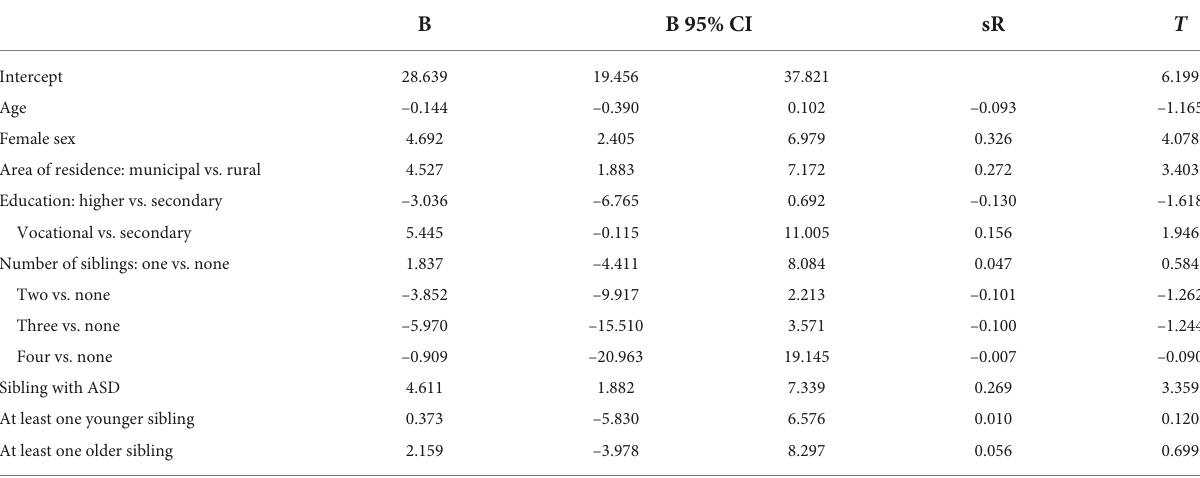
TABLE 3 Parameters of the linear regression model predicting the De Jong Gierveld Loneliness Scale score in the studied group of